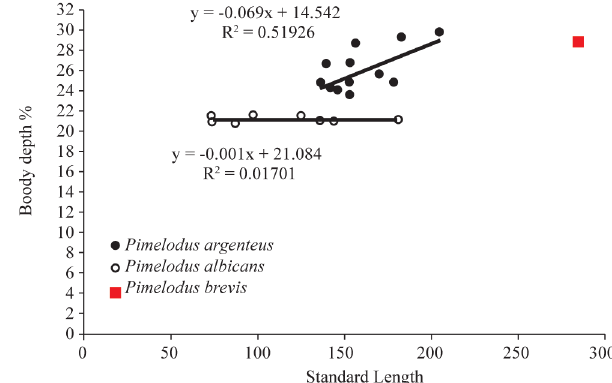
Fig. 5. Linear regression of percent of body depth on standard length of Pimelodus argenteus , P. albicans , and P. brevis . R 2 = coefficient of